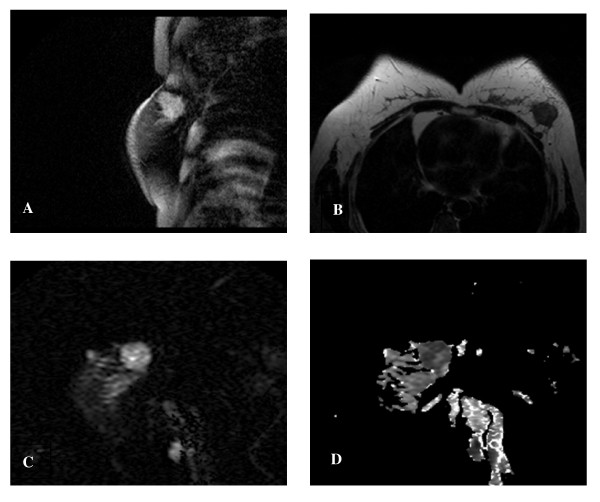
45-year-old woman with IDC in the left breast. A: WATS T1-weighted sagittal scan showed irregularly mass in the left breast with hyperintense signal. B: T2-weighted transverse scan showed the lesion was hypointense with spicule sign. C: EPI-DWI sagittal scan showed lesion with slightly inhomogeneity hyperintense in DWI. D: Inhomogeneity hypointense was found in ADC map (b = 500) and the ADC was 0.94 ± 0.19 ± 10-3mm2/s.